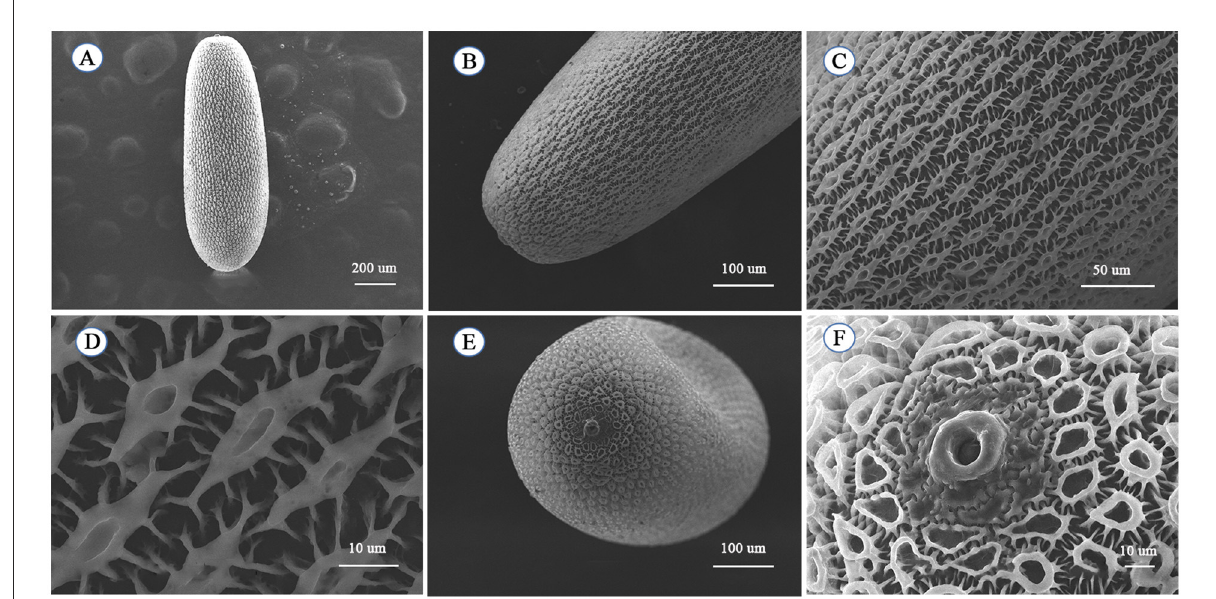
FIGURE2 Egg of Eristalinus arvorum : (A) front view of the egg, (B) the thinner end of the egg, (C) egg reticulation, (D) egg reticulation, (E) egg top view, (F) egg hole.